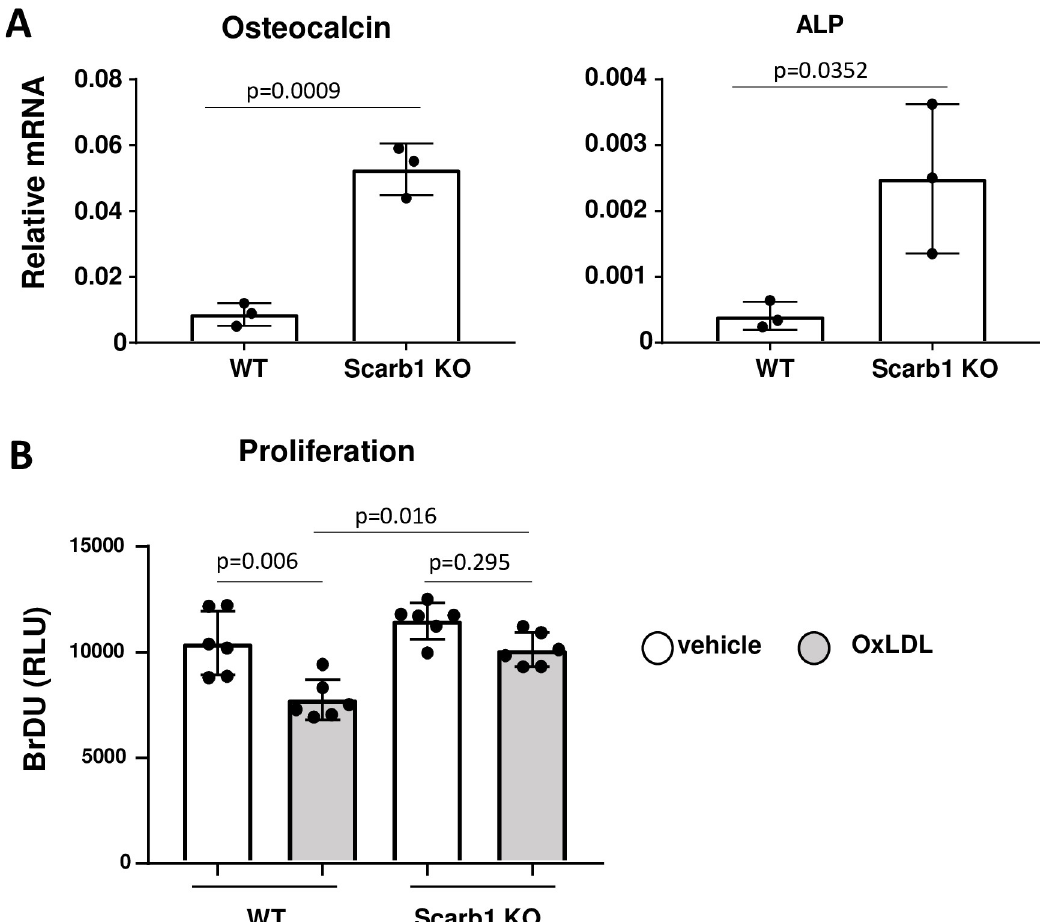
Fig 1. Deletion of Scarb1 increases osteoblast differentiation and protects agains the anti-proliferative effects of OxLDL. (A) The expression of osteocalcin and alkaline phosphatase was quantified with RT-PCR in calvaria-derived osteoblasts from new born C57BL6/J (n = 5) and Scarb1 KO mice (n = 2) cultured for 21 days. Transcripts were normalized to the housekeeping gene MRPS2. Data analyzed by student t-test. (B) Proliferation was measured with Bromodeoxyuridine (BrDU) incorporation in bone marrow- derived osteoblasts from 4–5 month-old WT and Scarb1 KO mice (n = 3/group) 3 days after direct addition to the cultures of vehicle or OxLDL (50 μ g/ml). Data analyzed by ANOVA, p-values were adjusted using the Holm-Sidak multiple comparison procedure. Data are shown as individual values with mean and standard deviation. All measures were performed in triplicate cultures. ALP, Alkaline phosphatase. RLU, relative light unit.